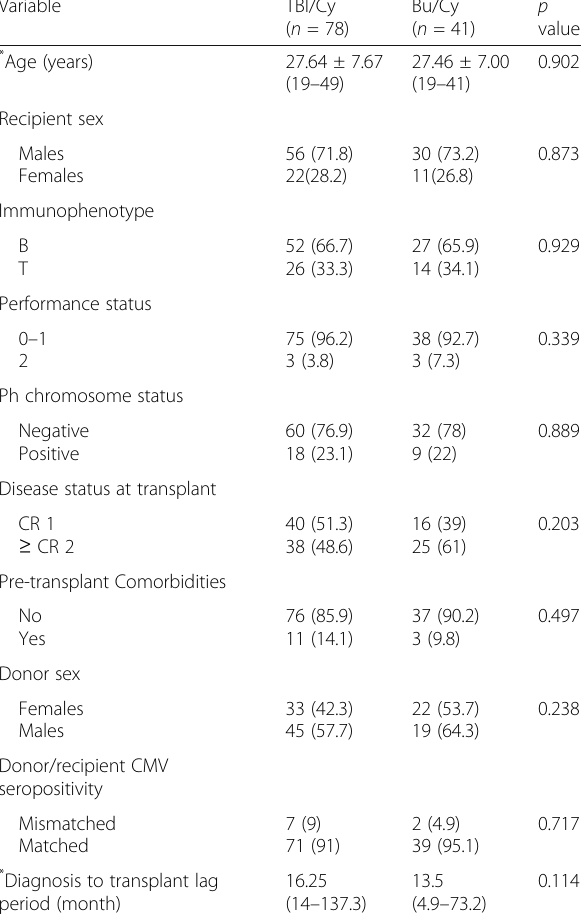
Table 1 Baseline characteristics of the study population